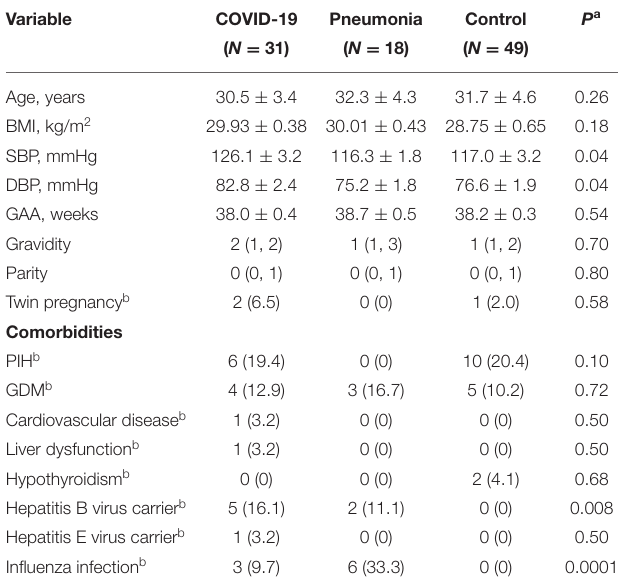
TABLE 1 | Baseline characteristics and clinical features of pregnant